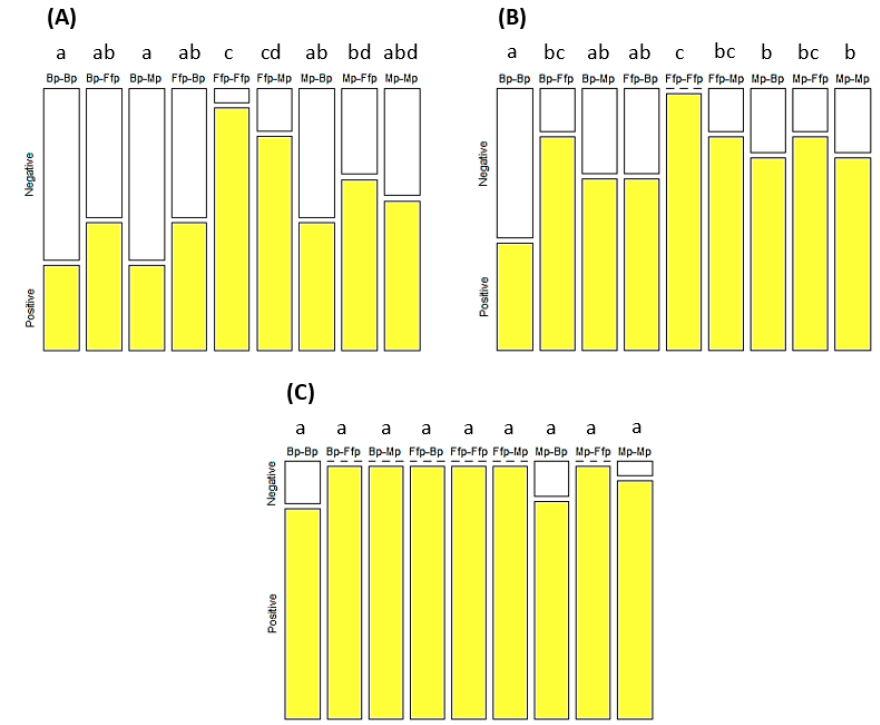
Figure 4. Percentage of PLRV-infected (positive) and non-infected (negative) tobacco after seven ( A ), eleven ( B ), and fifteen ( C ) days of incubation. Treatments were based on combinations of B. bassiana -inoculated plants (Bp), M. acridum -inoculated plants (Mp), and fungal-free plants (Ffp), as well as a control, as source (two first letters) and recipient (two last letters) plants. Treatments followed by different letters were significantly different ( p < 0.05). n = Bp–Ffp, Mp–Ffp, and Ffp–Ffp = 36; Bp–Bp = 32; Bp–Mp = 29; Ffp–Bp = 26; Ffp–Mp = 30; Mp–Bp = 25; and Mp–Mp = 30.